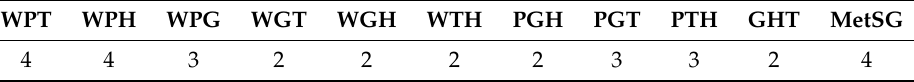
Table 11. Numbers of hidden neurons from each ANN of the MetS types.